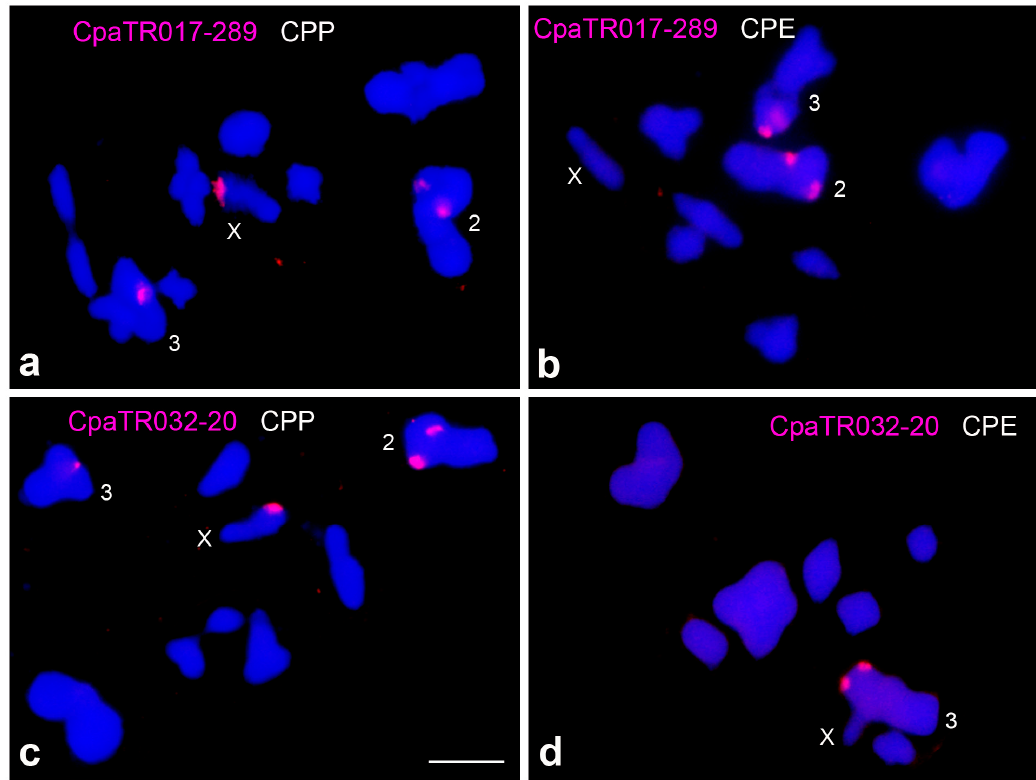
Figure 3. Presence of two TR families on the distal region of the X chromosome in CPP, which are absent in CPE: CpaTR017-289 ( a , b ) and CpaTR032-20 ( c , d ). Note that these TRs are also present on autosomes 2 and 3 (see also Tables 2 and 3). Bar = 5 μ m.